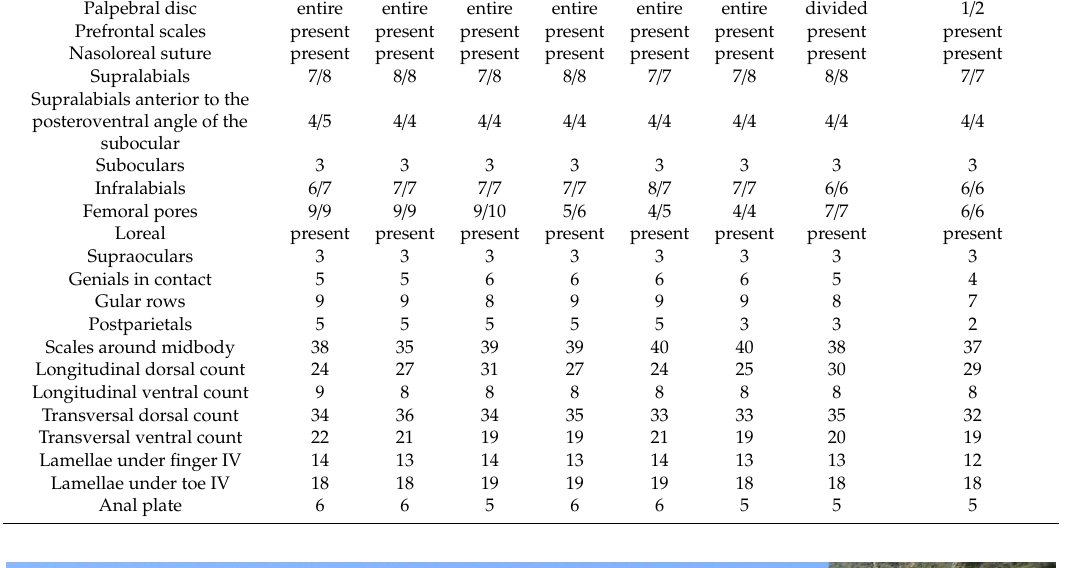
posteroventral angle of the subocular Suboculars